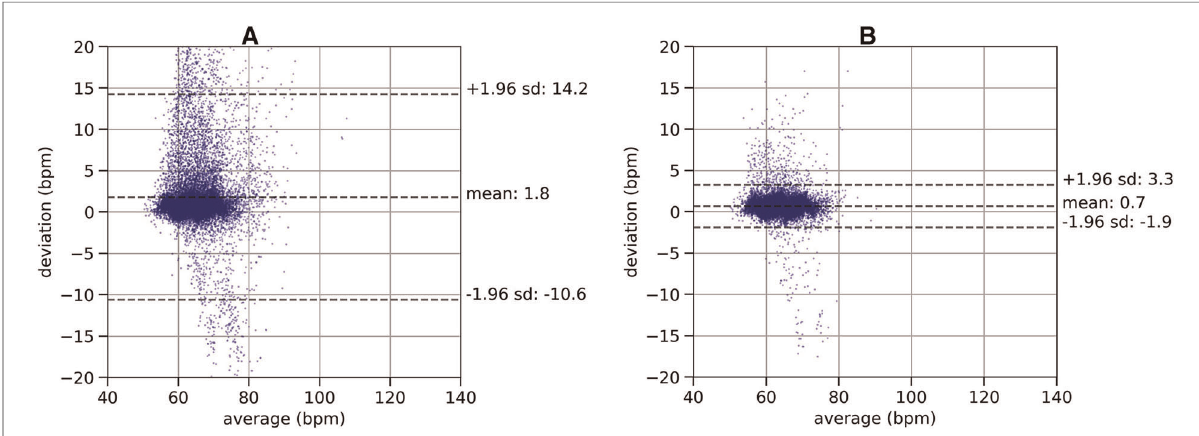
FIGURE 5 Plot ( A ): Bland-Altman plot of a recording of heart rate without quality fi ltering, comparing the in-ear sensor ’ s heart rate measurement with the ECG over a recording time of 63 h. The plot shows the deviations of the heart rate values ( y -axis) relative to the mean of the two methods ( x -axis). The dashed lines indicate the mean value of the deviations (bias) and the lower (LLOA) and upper (ULOA) limits of agreement as calculated as bias + 1 : 96 (cid:3) SD . This leads to a bias of 1.8 bpm and limits of agreement of LLOA ¼ (cid:4) 10 : 6 bpm and ULOA ¼ 14 : 2 bpm. Plot ( B ): Bland-Altman plot of a recording of heart rate with quality fi ltering, comparing the in-ear sensor ’ s heart rate measurement with the ECG over a recording time of 46 h. The same data set as in left plot is shown, removing the data points below the quality threshold. The lower (LLOA) and upper (ULOA) limits of agreement as calculated as bias + 1 : 96 (cid:3) SD . Removing low quality data points leads to a bias of 0.7 bpm and limits of agreement of LLOA ¼ (cid:4) 1 : 9 bpm and ULOA ¼ 3 : 3